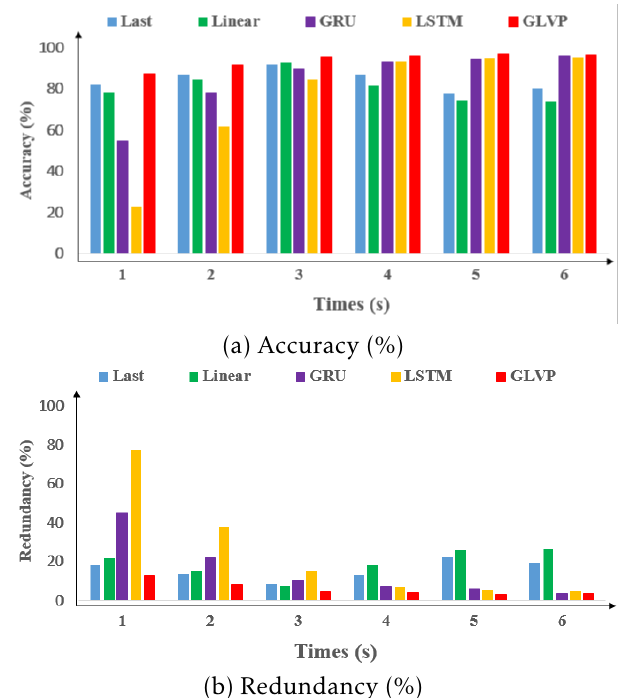
Figure 8. Viewport estimated the performance of the methods reviewed at each early motion trace of Viewport position #2 In another case study viewport position #2 as presented in Figure 8, GLVP also outperforms LAST, LINEAR, LSTM, and GRU. That proves that GLVP works well in di ff erent cases of viewport